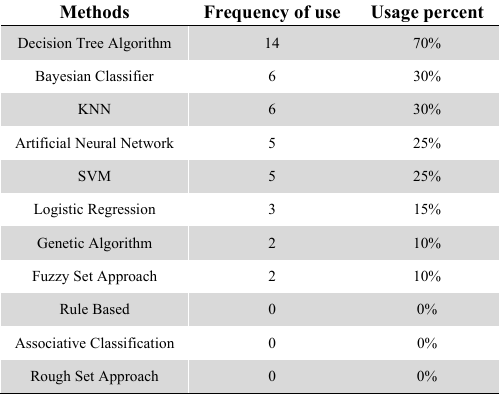
Comparison of the classification methods